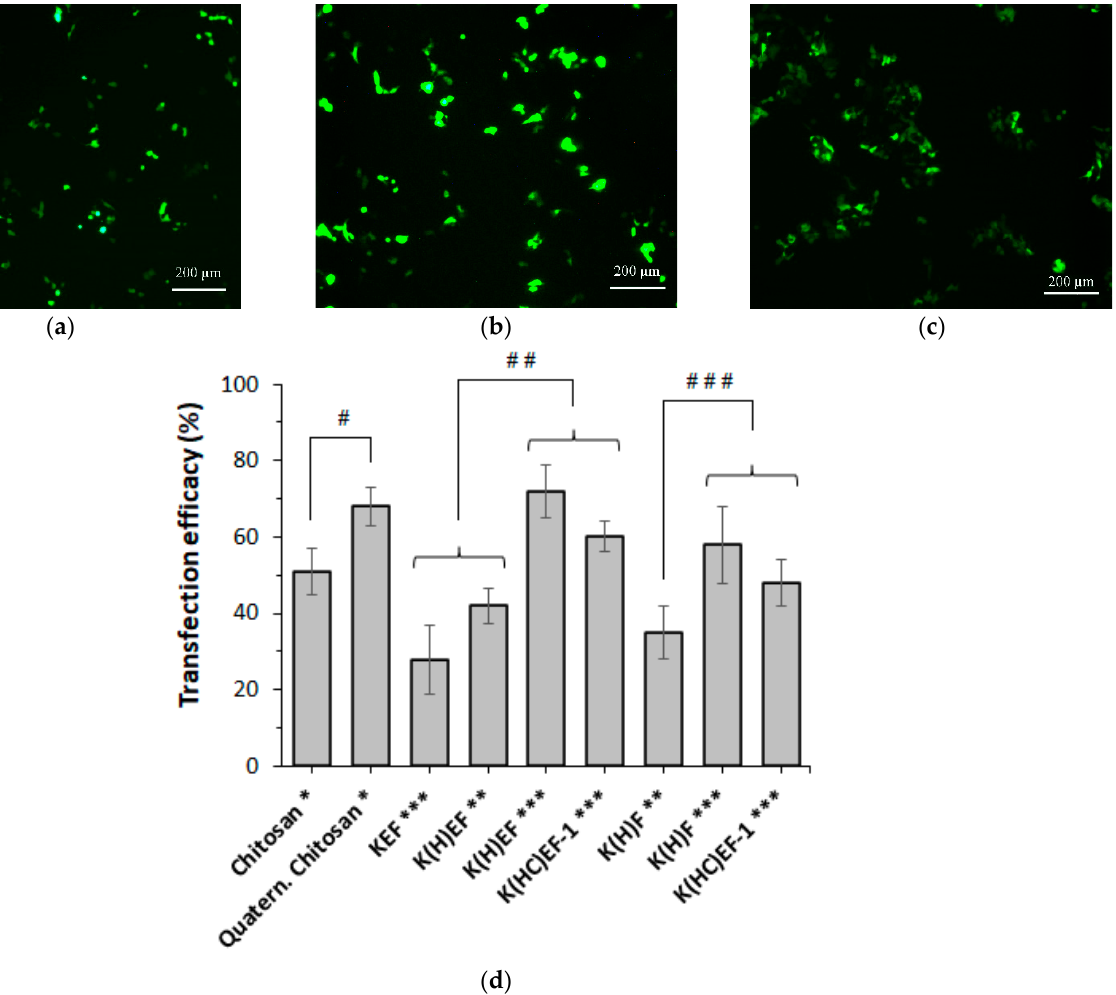
Figure 10. Transfection of pEGFP-N3 to HEK 293 cells with the use of various polymer delivery systems: ( a , b ) Fluorescence microscopy after 5 days of cell incubation with polymer/pDNA complexes (GFP channel, ×10). Samples: chitosan ( a ), K(H)EF ( b ) and K(HC)F-1 ( c ); ( d ) comparative transfection efficacy for the tested polymer/pEGFP-N3 systems. pDNA content: *—500 ng (polymer/pDNA mass ratio was 100:1), **—100 ng (polymer/pDNA mass ratio was 50:1), ***—200 ng (polymer/pDNA mass ratio was 100:1). Statistics: #— p ˂ 0.05, ##— p ˂ 0.005, ###— p ˂ 0.008.